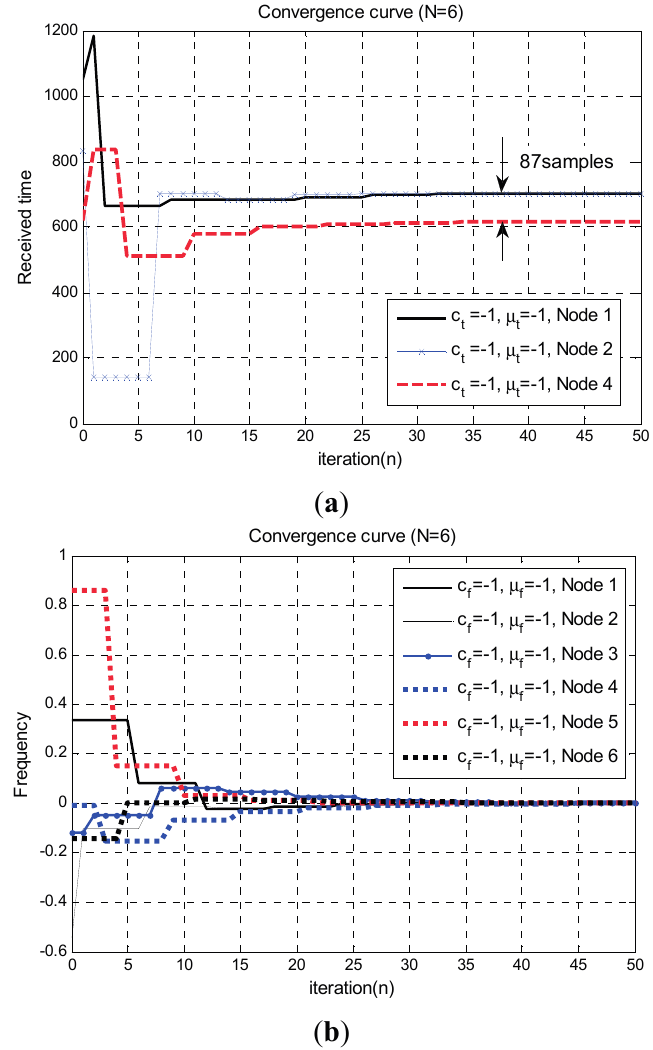
Figure 7. Convergence curve of the proposed synchronization technique in the multi-hop mesh network ( [ , , , , , , ] [432,832,1048,618,281,296,149] τ τ τ τ τ τ τ = ). ( a ) Convergence curve 12 13 23 34 45 56 46 of the proposed time-synchronization technique (at Node 3); ( b ) Convergence curve of the proposed frequency-synchronization